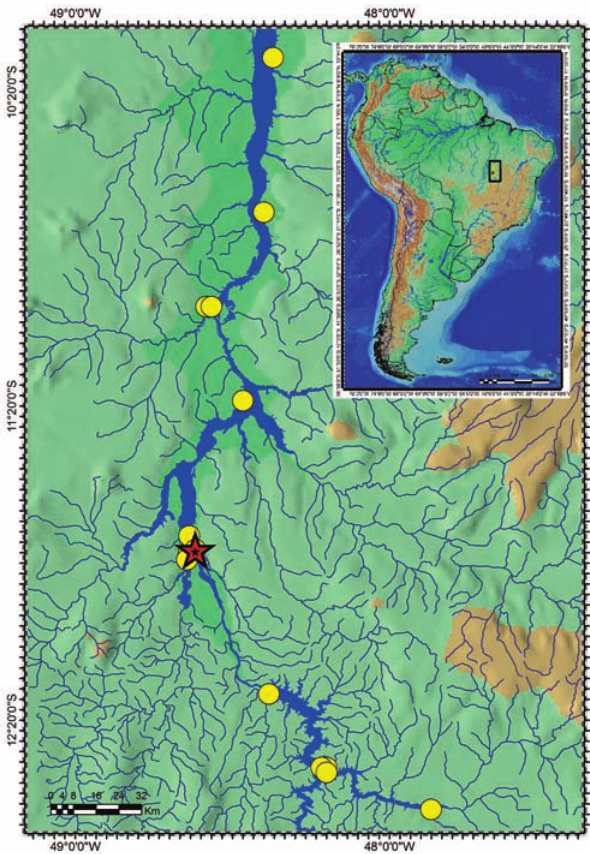
Fig. 3. Map of rio Tocantins drainage, showing the known distribution of Tetragonopterus akamai . Some symbols represent more than one lot or locality. Red star indicates the type locality. Inset depicts the area of South America displayed in the